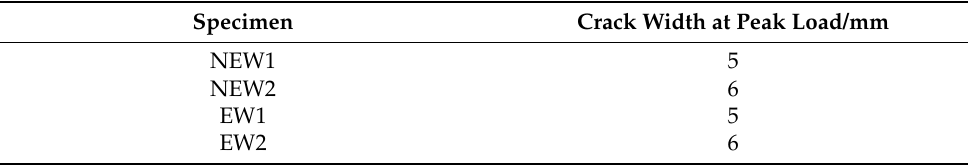
Table 3. Comparison of crack width at peak